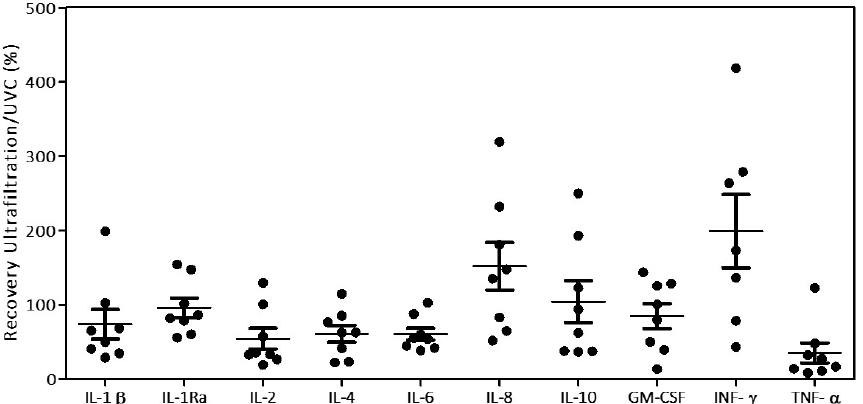
Figure 3. Effects of the virus decontamination methods (using UVC irradiation and AMICON ® - 100 kDa ultrafiltration) on the recovery of several cytokines and chemokines from BAL samples. Distribution plot indicates the cytokine/chemokines recovery upon treatments, expressed as ultrafiltration/UVC treated ratio in percentage (black spots), average (black horizontal dash) and the standard errors are reported for each analyte.